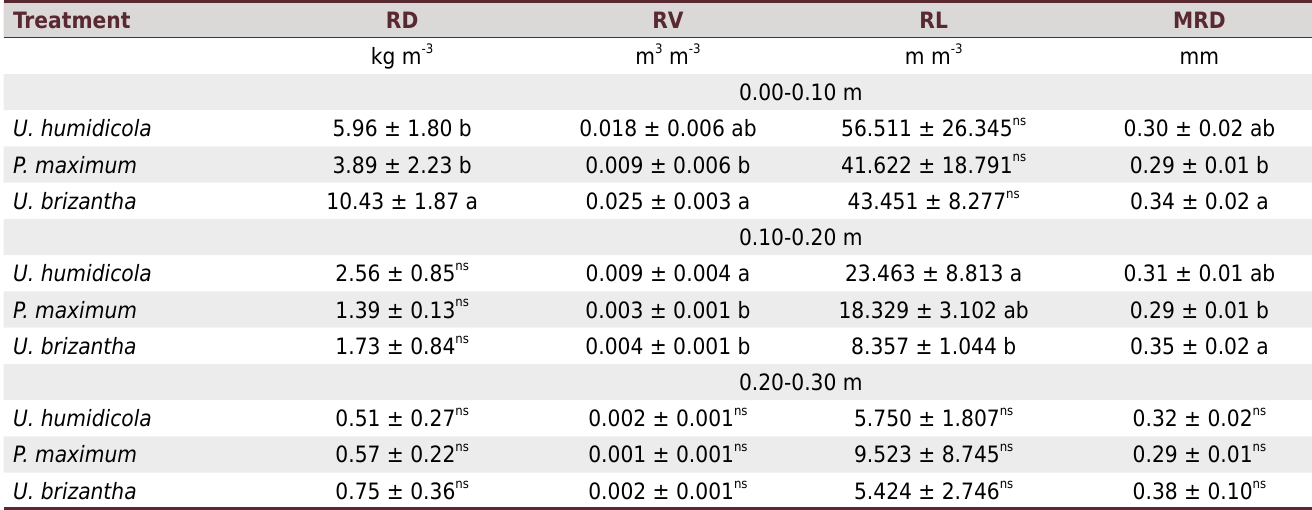
Table 4. Root density (RD), root volume (RV), root length (RL), and mean root diameter (MRD) of the three grasses in the 0.00-0.10, 0.10-0.20, and 0.20-0.30 m layers of the constructed minesoil after 58 months of the experiment